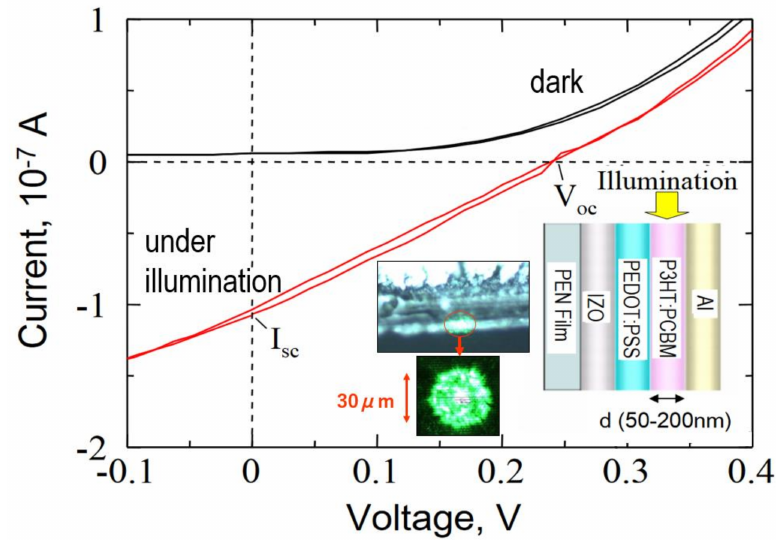
Figure 10. I-V characteristics of the cell in the dark and edge-illumination configuration. Left top inset is the front view of the edge facet, left bottom inset is the beam shed on the edge, and right inset shows the illumination configuration. (Reproduced from [32], Engineering Research Publication,